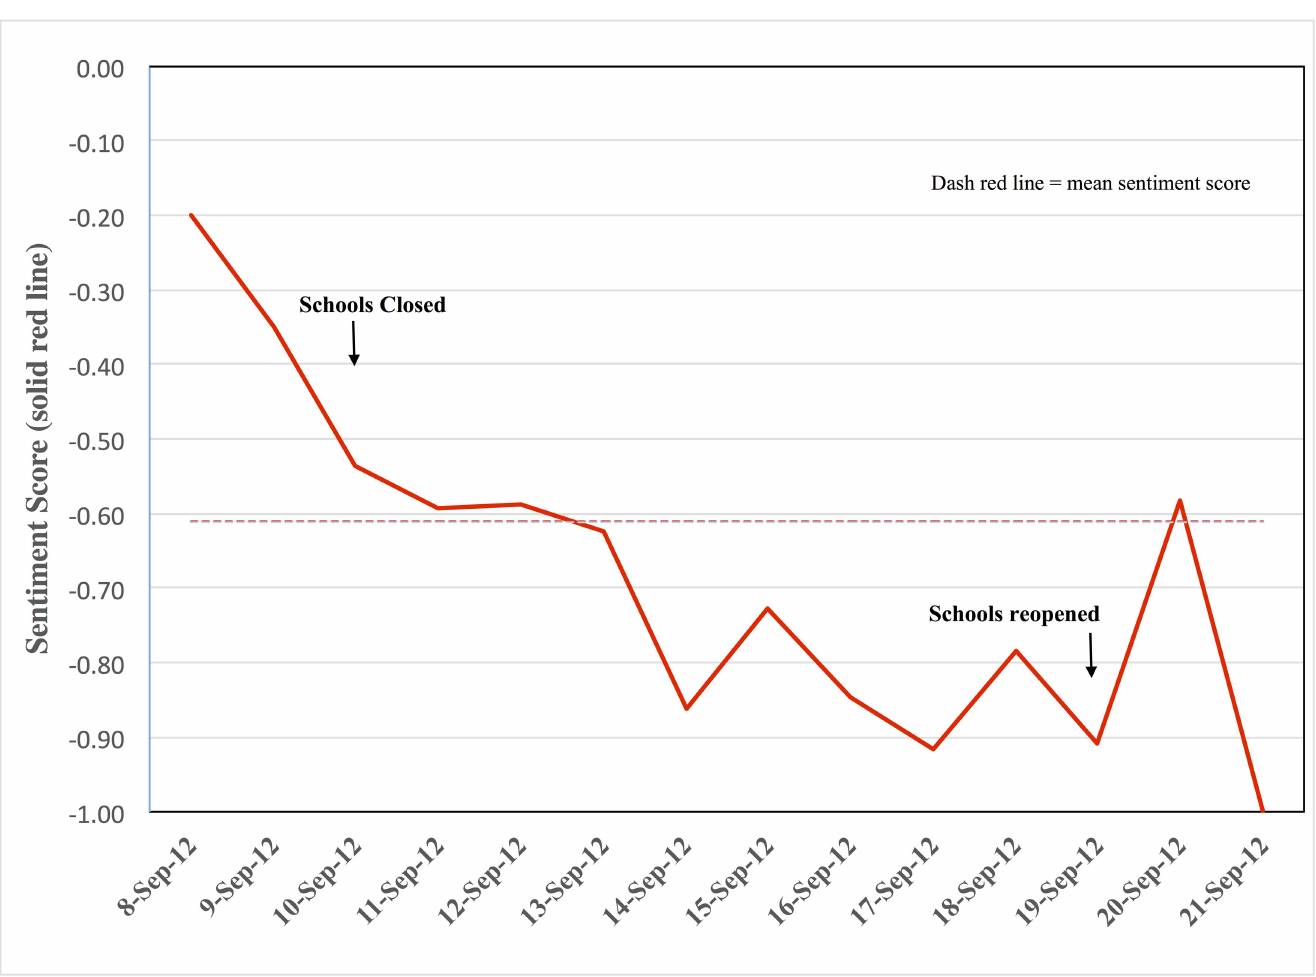
Fig 2. Sentiment score of relevant posts identified from social media by date. Relevant posts mentionedimpact of unplanned school closure due to Chicagoteachers’ strike from September 8–21 (two days before to three days after strike) on students and their families (N = 930). Sentiment score was calculated as: (positive posts—negative posts)/(positive posts + negative posts + neutral posts) a-b . a Sentiment score < 0 suggests negative sentiment; score > 0 suggests positive sentiment. b Score on September 21 reflects only four relevant posts, all expressing negative sentiment.